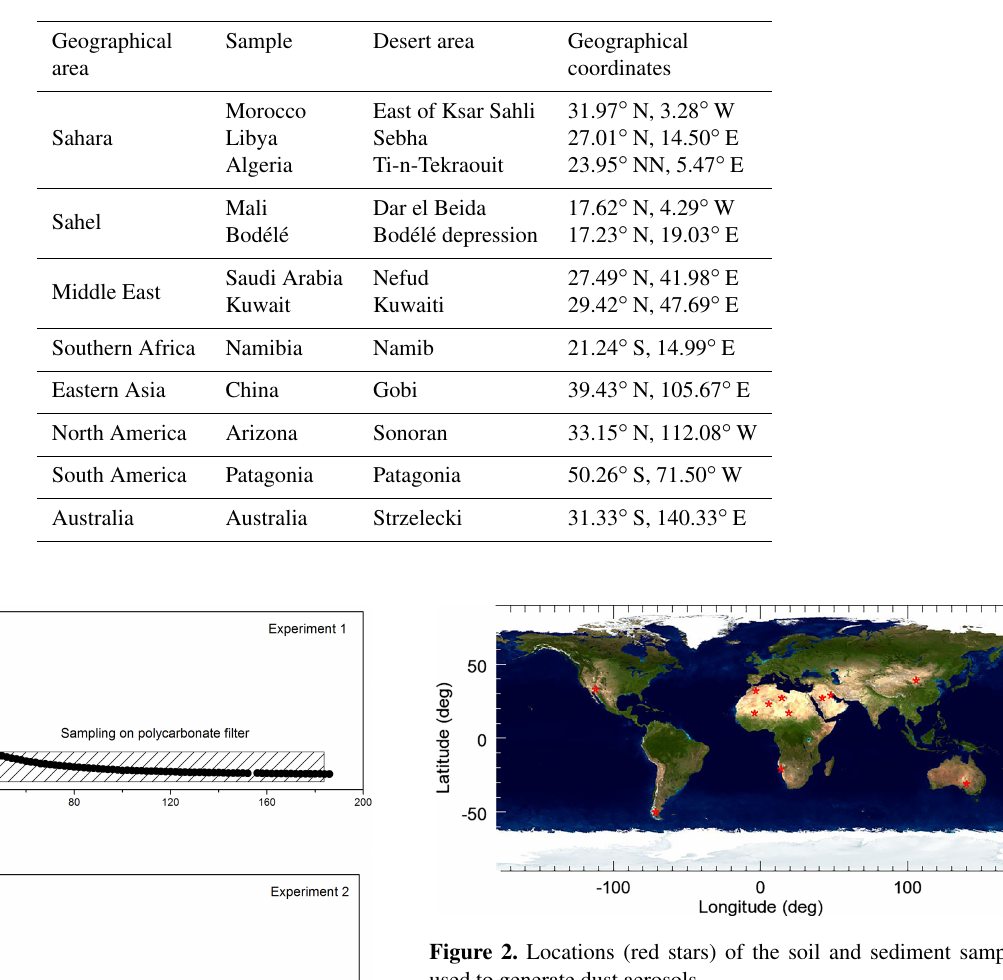
Table 2. Geographical information on the soil samples used in this work.